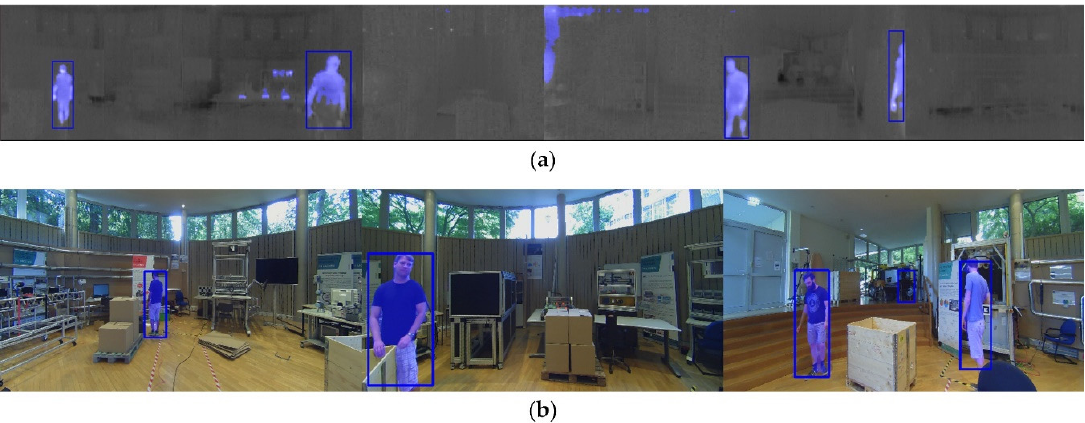
Figure 7. Human co-worker detection. ( a ) Thermal images T j ; ( b ) RGB images RGB i